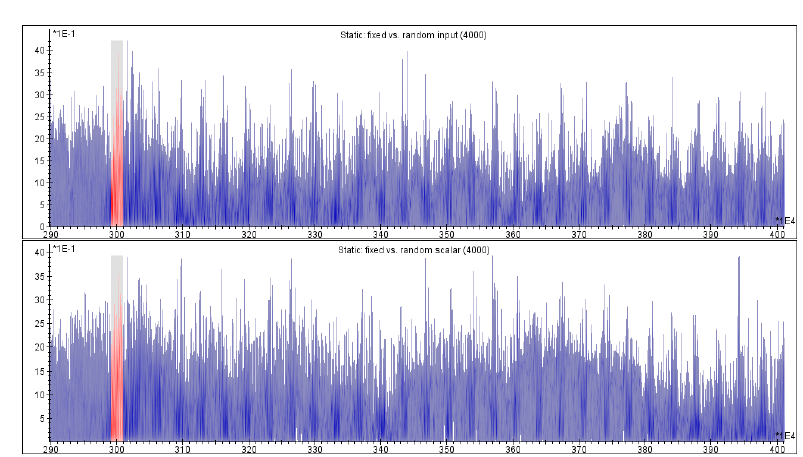
Figure 3: Static imp. TVLA (2 . 9-4 . 0ms): fixed vs random point (top) & scalar